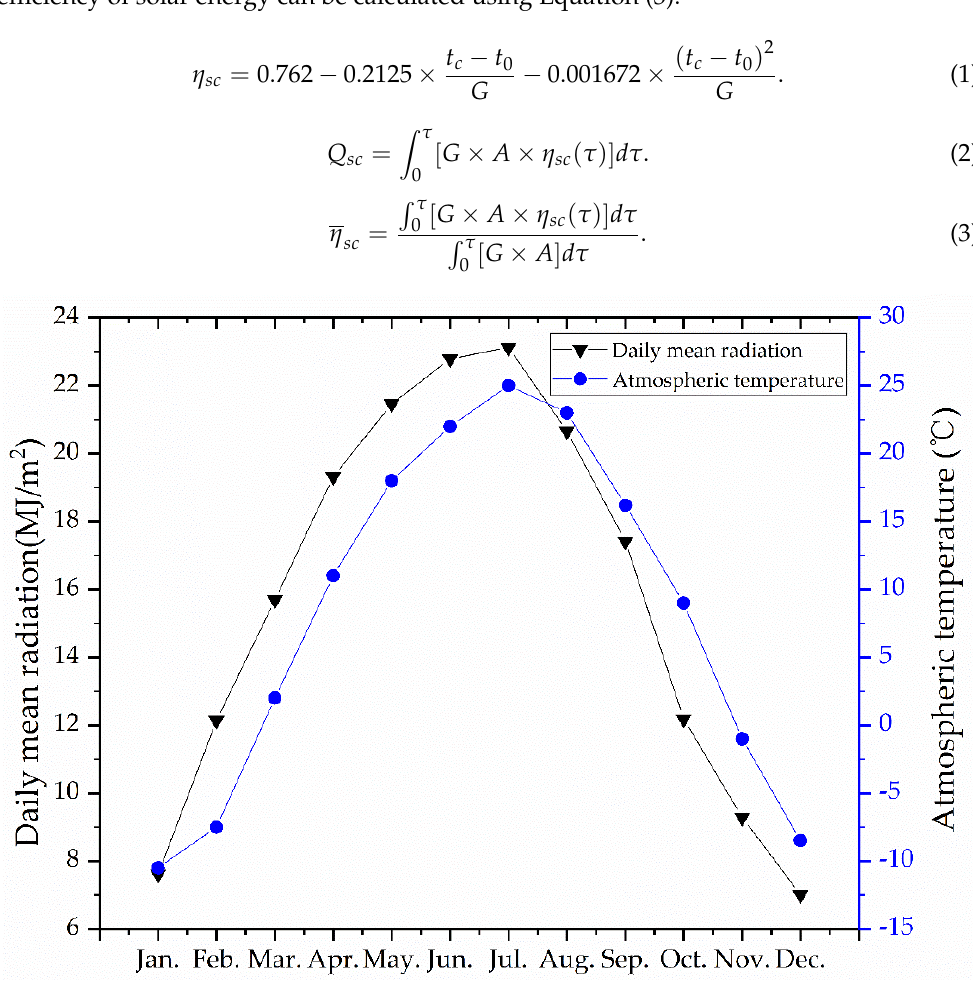
Figure 2. Meteorological parameters in the Chifeng city of China.